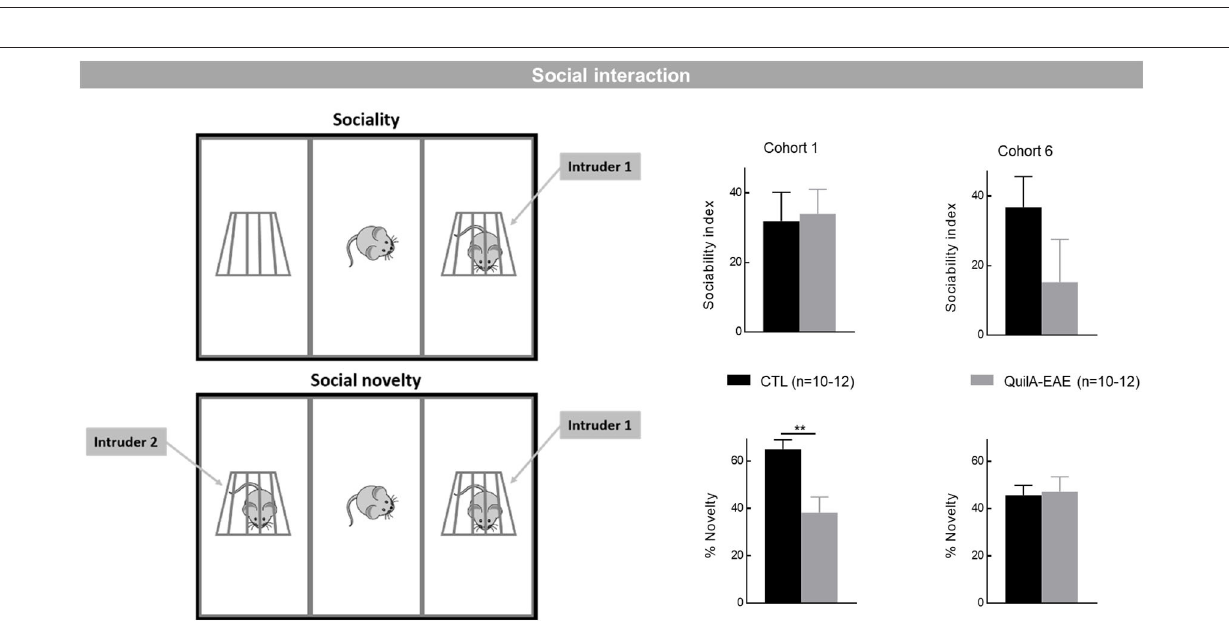
FIGURE 4 | induced by rubbing the whisker pad with a smooth paintbrush made of marten hairs (top) or a rough paintbrush made of pig bristles (bottom). (B) Mechanical static sensitivity to three stimuli of calibrated air puffs (duration and intensity): Stimulation 1 (0.16s, 1.8 mpsi), Stimulation 2 (0.14s, 23.0 mpsi), Stimulation 3 (0.48s, 26.4 mpsi). Mechanical static sensitivity expressed as the mean nociceptive score ± SEM induced by each air puff. (C) Cold allodynia expressed as time spent rubbing or scratching face ± SEM for 1min after acetone drop deposition. Statistical analysis was performed using two-way ANOVA followed by post-hoc